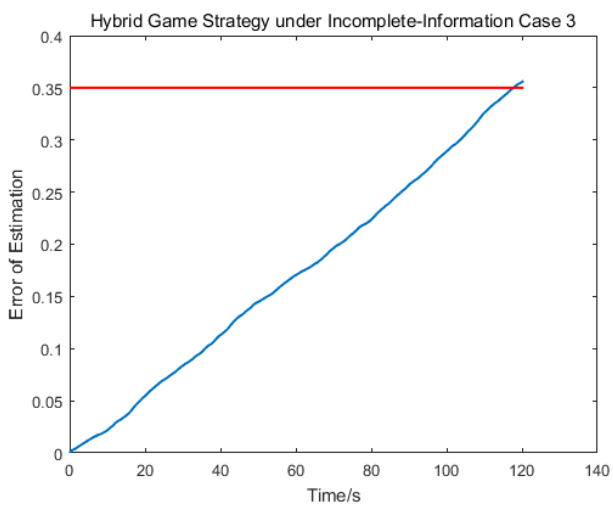
Figure 21. Error estimation of